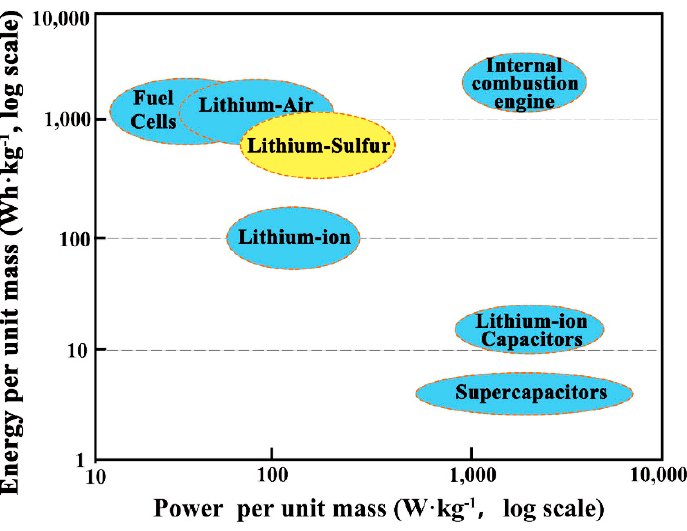
Figure 1. Energy storage Ragone plot.